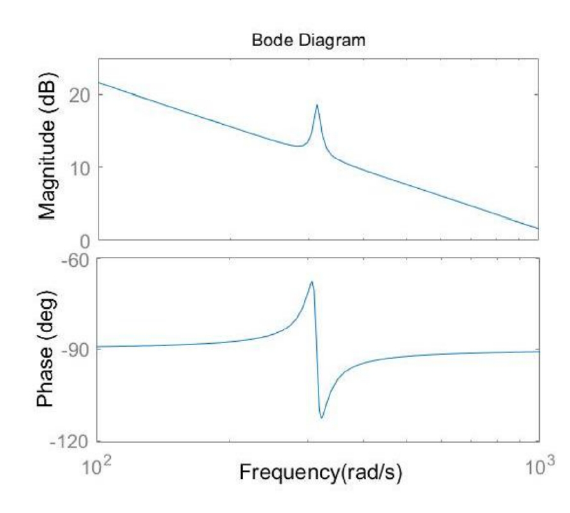
Fig. 5. Bode diagram of open loop transfer function.